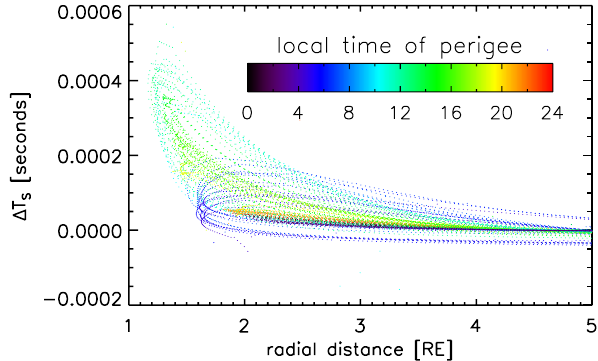
Fig. 4. Spin period change ( 1T S ) due to Earth radiation versus radial geocentric distance to the Earth. The colours show the local time (in hours) of the perigee